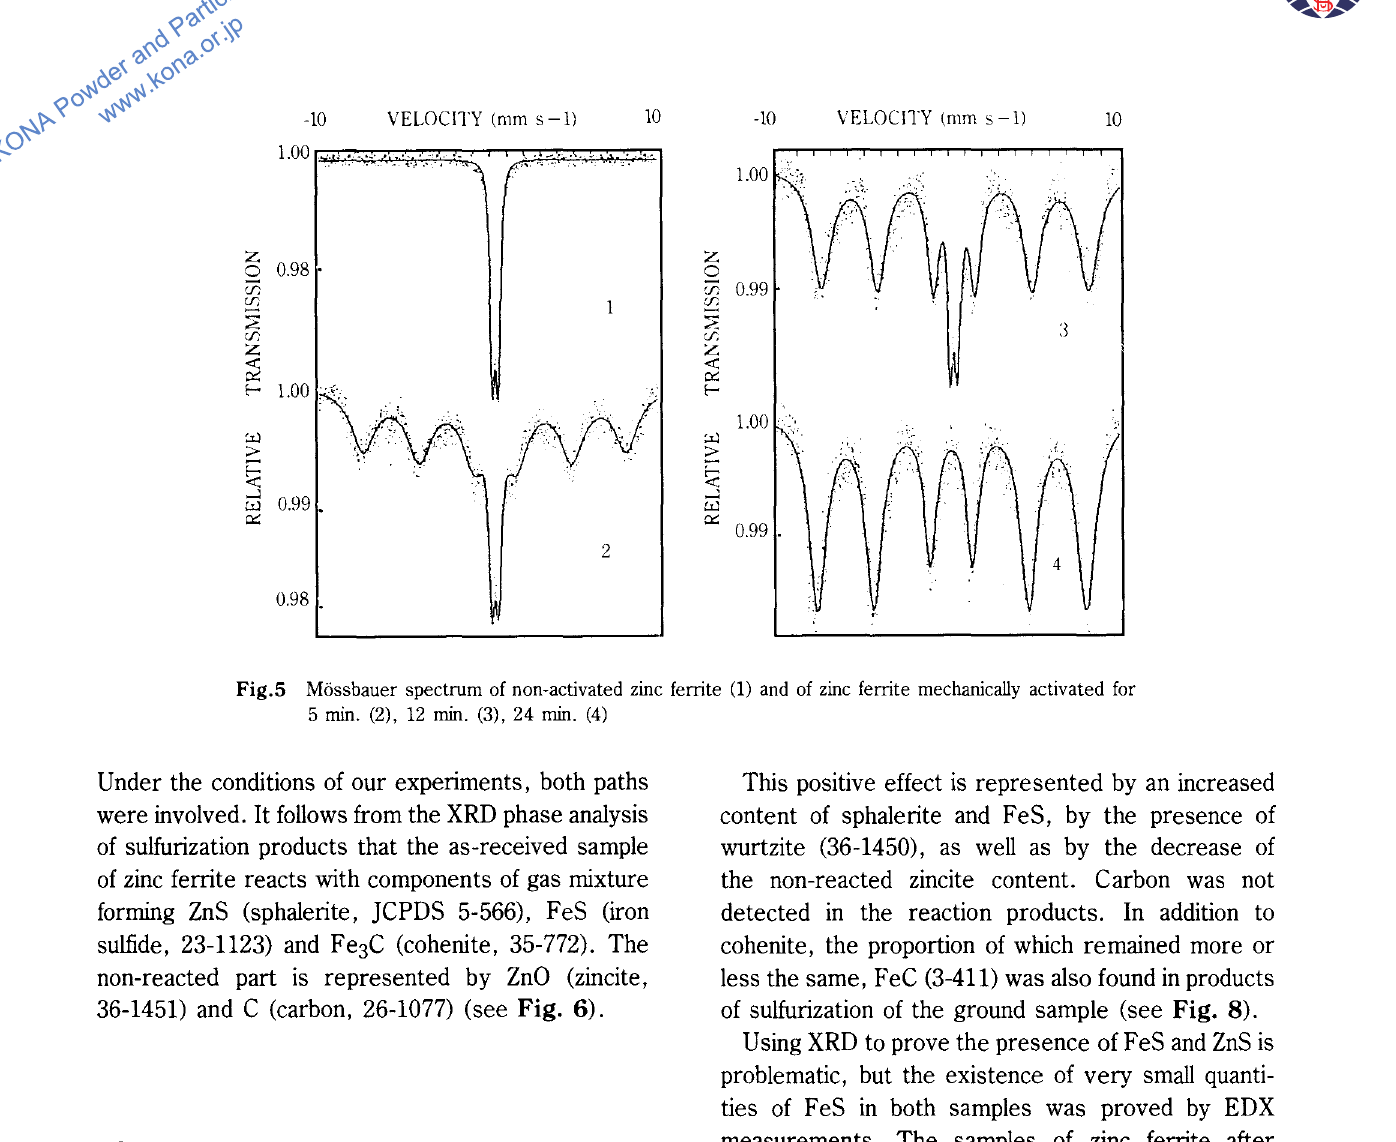
Fig. 6 Diffraction pattern of non-activated zinc ferrite after sulfurization C = Carbon I = Iron sulfide S = Sphalerite Coh = Cohenite Z = Zincite